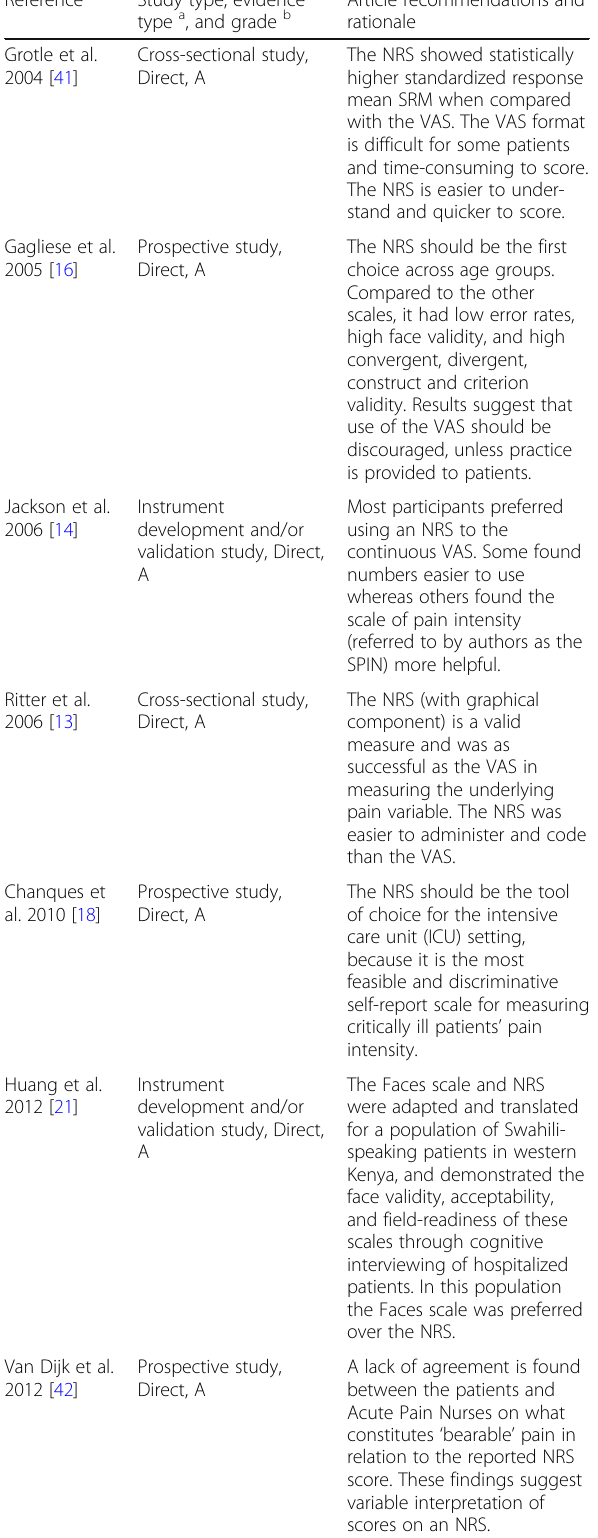
Table 2 Summary of key evidence to support the numeric rating scale (NRS) in pain